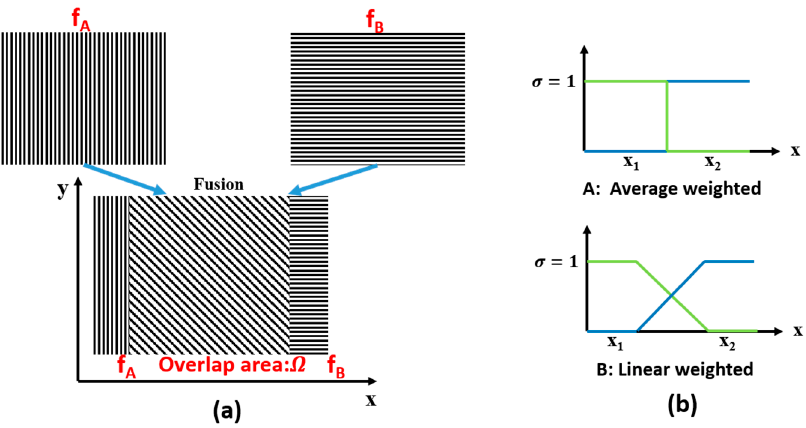
Figure 3. Image fusion algorithms and examples of different weighted function. ( a ) The overlapped regions are indicated by the slant dashed line. The two images on the left and right are to be stitched; ( b ) represents distinctive average features in overlapped region Ω . R and L are the region viewed exclusively in image f A and f B ( L⋂R = L⋂Ω = R⋂Ω = ∅ ).